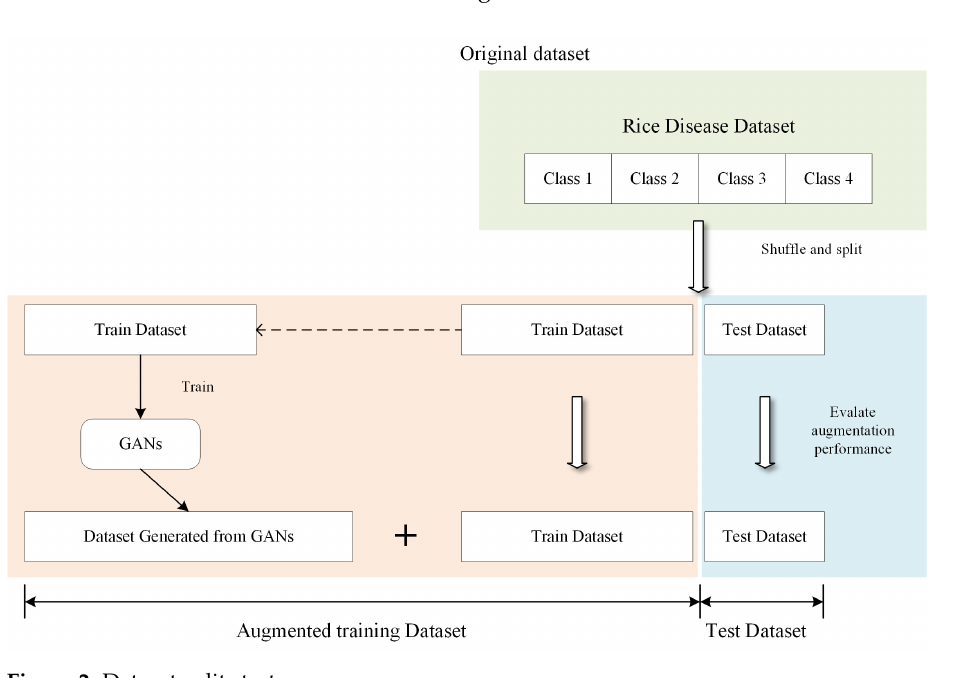
Figure 2. Dataset split strategy. Table 2. Details of the rice leaf disease train and test